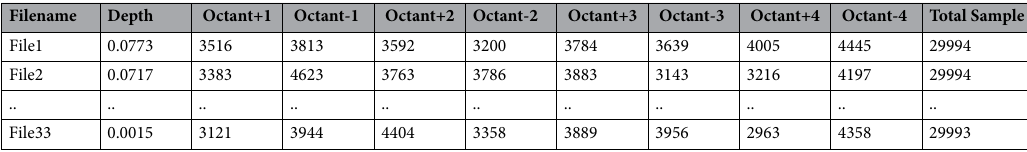
Table 9. Statistical parameters of turbulence obtained via P-SAT (Continued...).